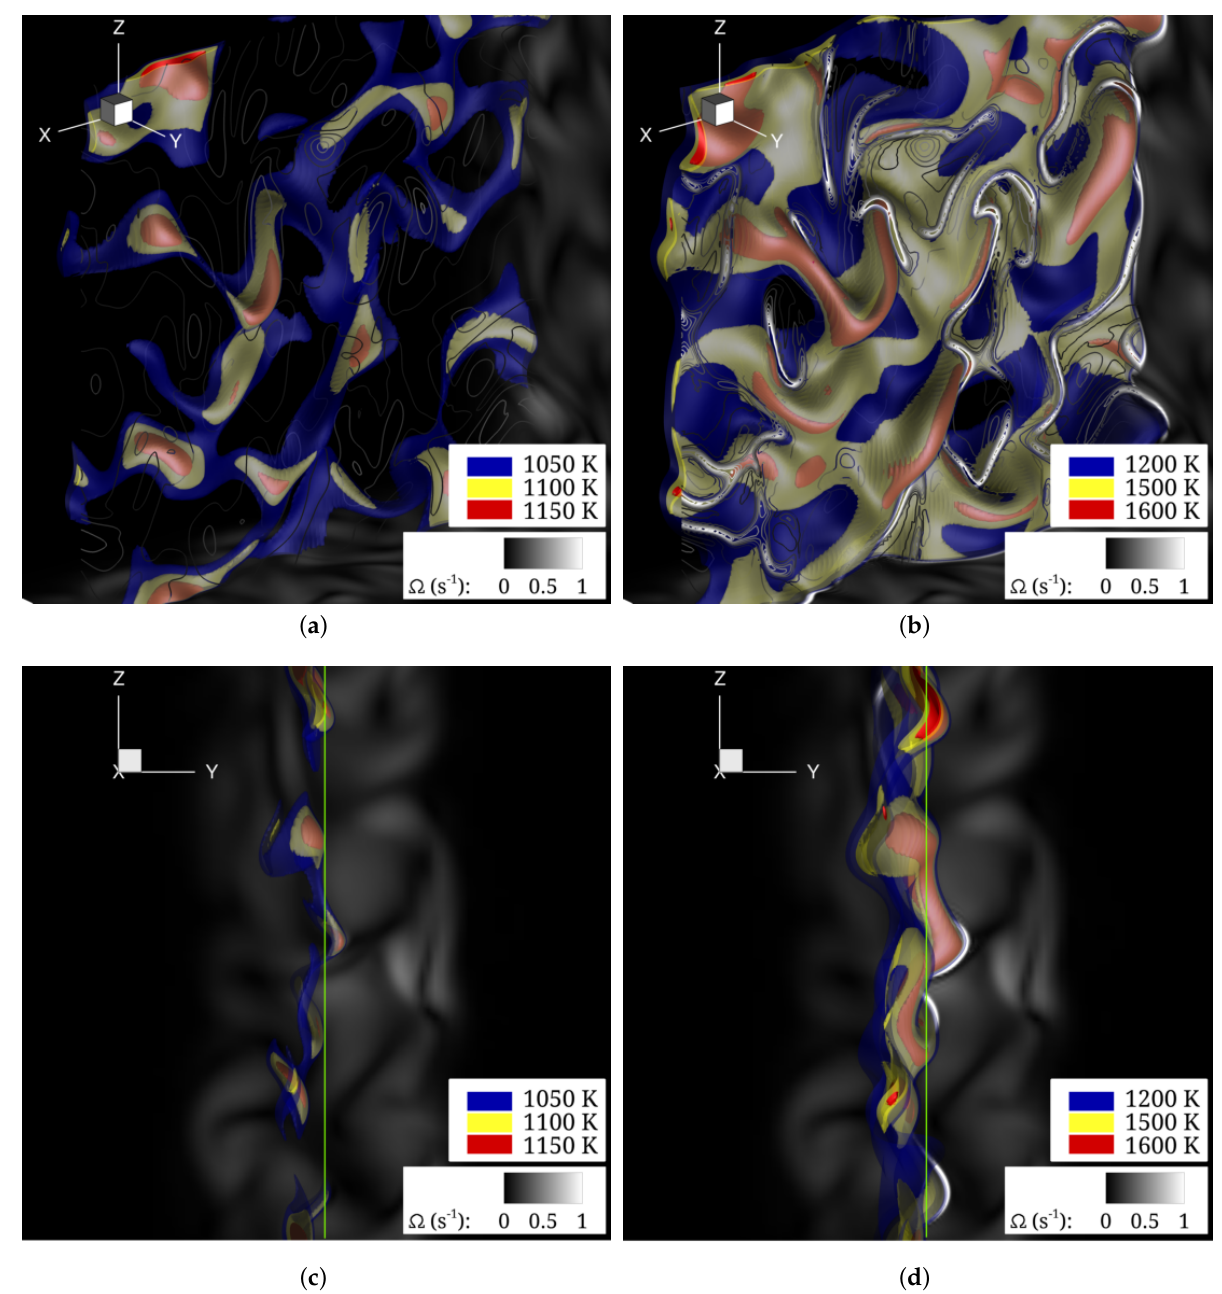
Figure 6. 3D temperature iso-surfaces and the vorticity contours. The results obtained for the case HAT-200 in two time moments: ( a ) t = 0.9 ms (3D view); ( b ) t = 1.0 ms (3D view); ( c ) t = 0.9 ms (‘y-z’ plane); ( d ) t = 1.0 ms (‘y-z’